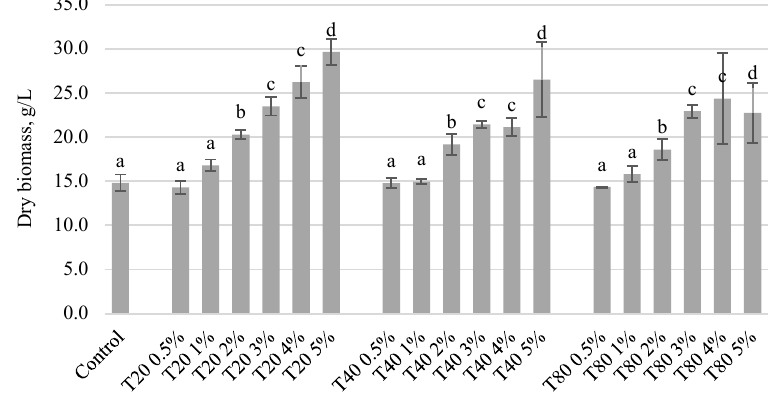
Fig. 2. R. glutinis dry biomass weight after 7 cultivation of days for control without Tween compared with supplementation of Tween 20 (T20), 40 (T40) and 80 (T80) with concentrations 0.5 %, 1–5 %. The letters a, b, c, d represent a statistically significant differences between means of biomass weight on 7 th day of cultivation as a function of polysorbates